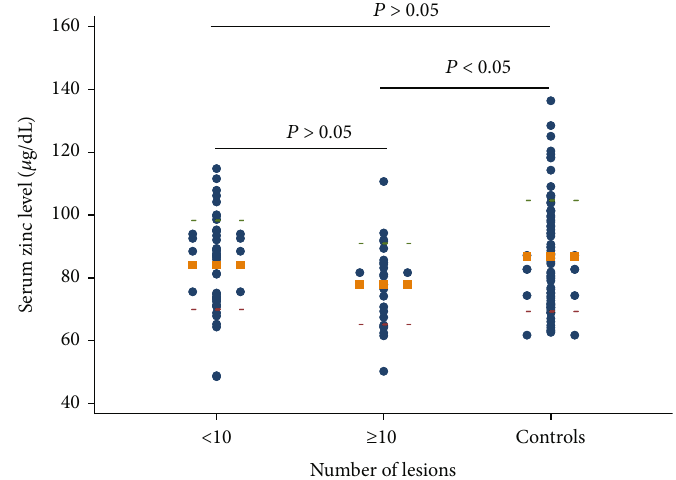
Figure 4: The serum level of zinc in relation to the number of lesions (Student ’ s t -test). The round dots show values of serum zinc level, and the orange square dot lines show mean